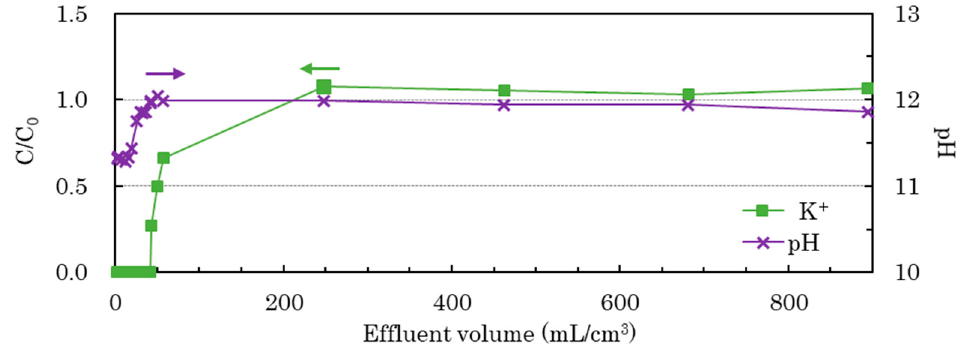
Figure 2. Changes in K + concentration and pH in the effluent fractions after passage through the SrTreat ® column.